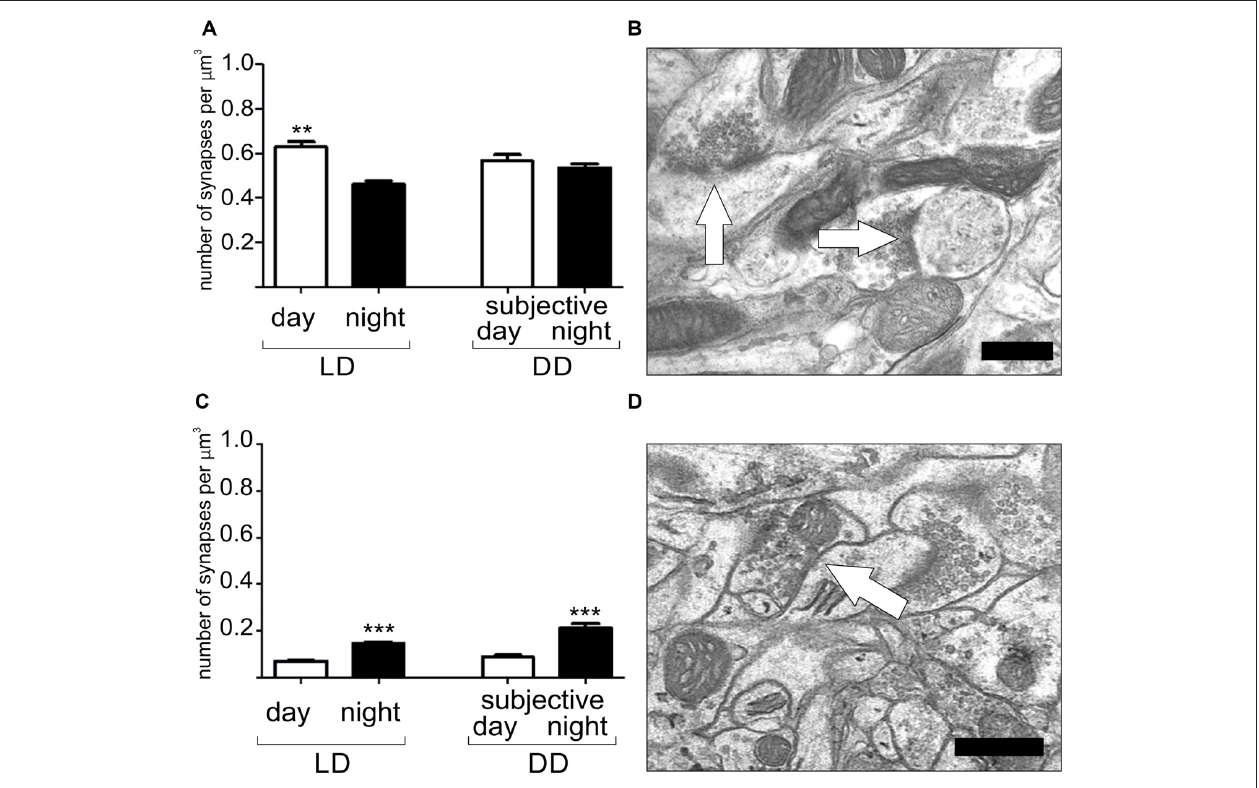
FIGURE 3 | Daily and circadian rhythms in the number of excitatory (A,B) and inhibitory synapses (C,D) in the barrel cortex of the mouse somatosensory cortex. Light and darkness (LD) 12:12–12 h of light and 12 h of darkness, DD–constant darkness. Scale bar: 0.5 µ m. Graphs show means ± SD, ∗∗ P < 0.01, ∗∗∗ P < 0.001 (Jasinska et al.,